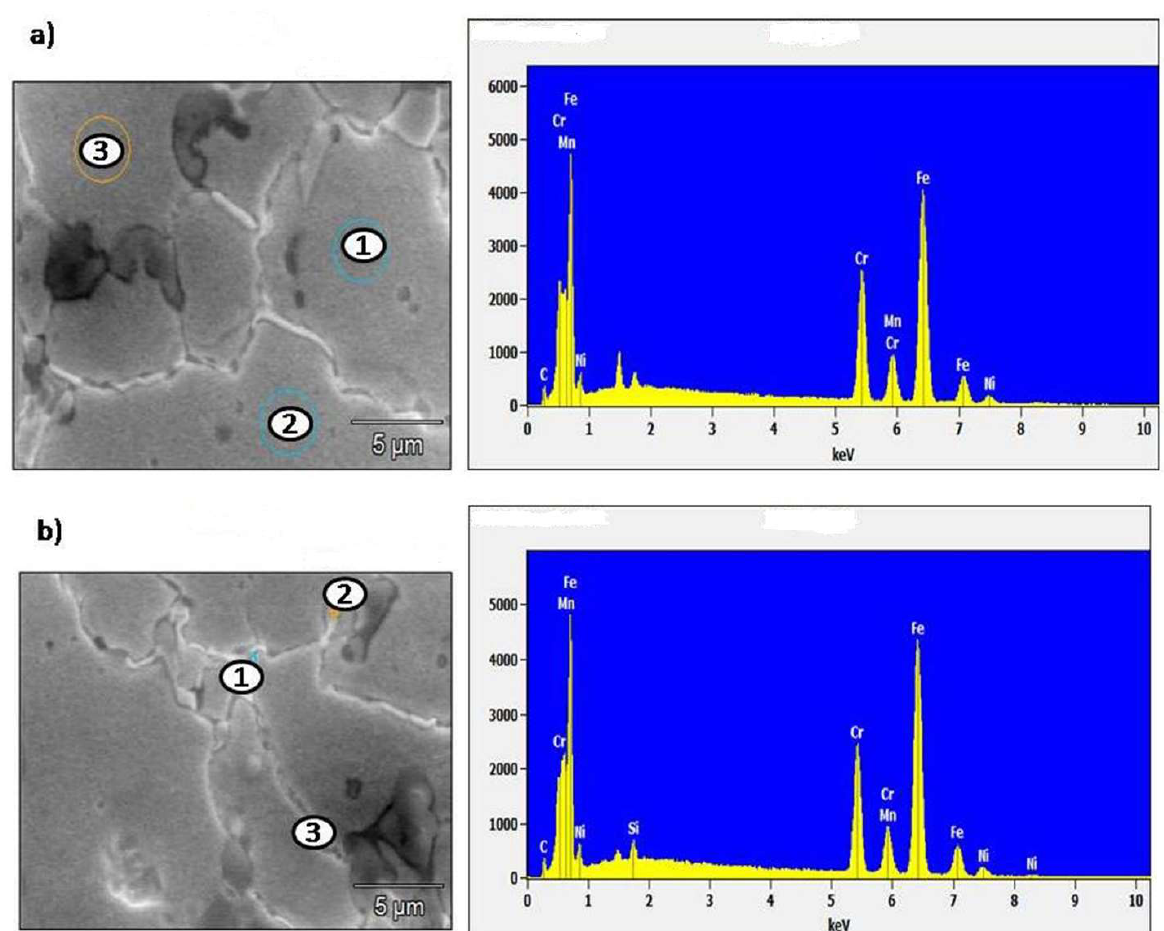
Figure 6. SEM-EDS analysis of 21-4N both at ( a ) grains and ( b ) grain boundaries.